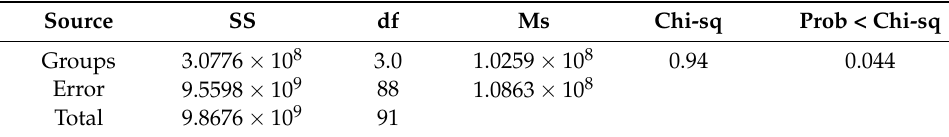
Table 8. The result of the Kruskal–Wallis H test.